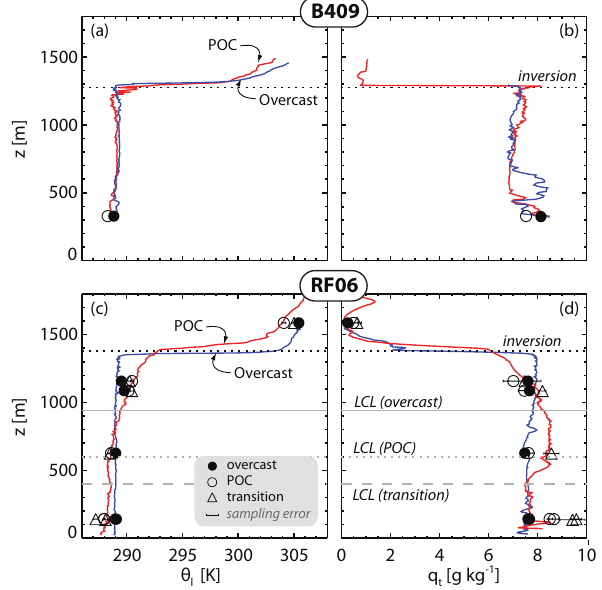
Fig. 7. Profiles from RF06 of mean values of (a,c) liquid potential temperature and (b,d) total water content, from straight and levels runs (symbols) in the POC, overcast, and transition regions. Data from both flight B409 (a,b) and flight RF06 (c,d) are shown. For B409, the two available profiles are shown. For RF06 repre- sentative example profiles are also shown for the POC (red, 120km from leading edge, 12:55–13:05UTC) and overcast (blue, 160km from leading edge, 10:50–10:56UTC) regions. Mean lifting condensation levels (LCLs) determined from the subcloud runs are shown for RF06 case. Profile locations are shown in Figs. 3 and 4.